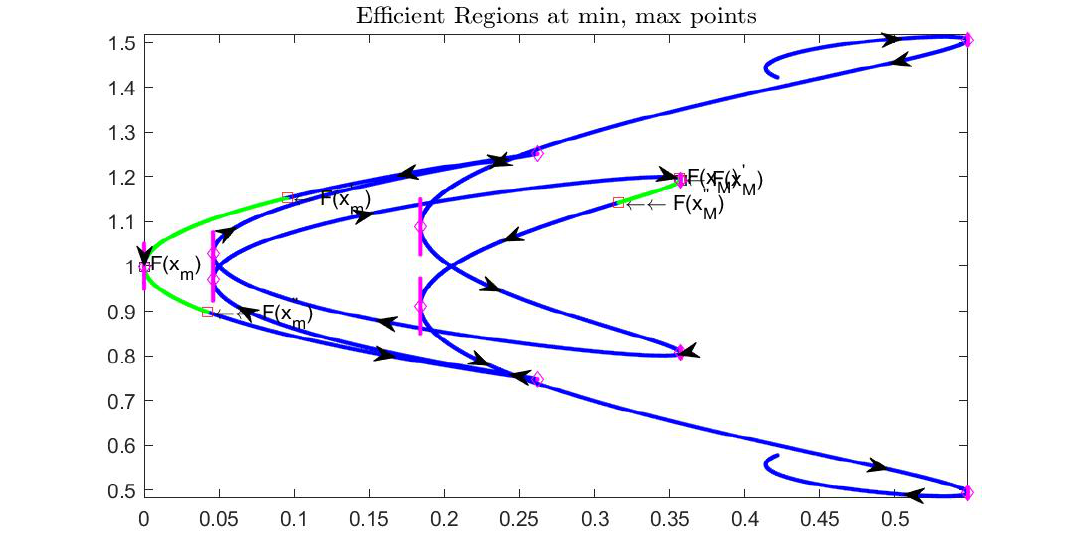
Figure 15. Complete Example: function F ( x ) is represented in midpoint form, together with the efficient points corresponding to x m and x M